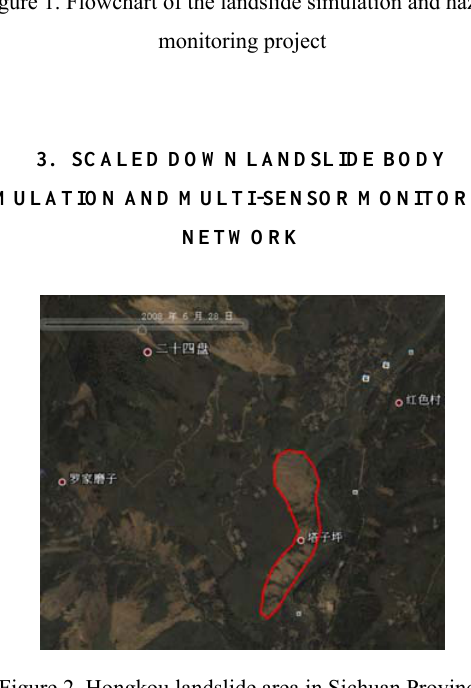
Figure 1. Flowchart of the landslide simulation and hazard